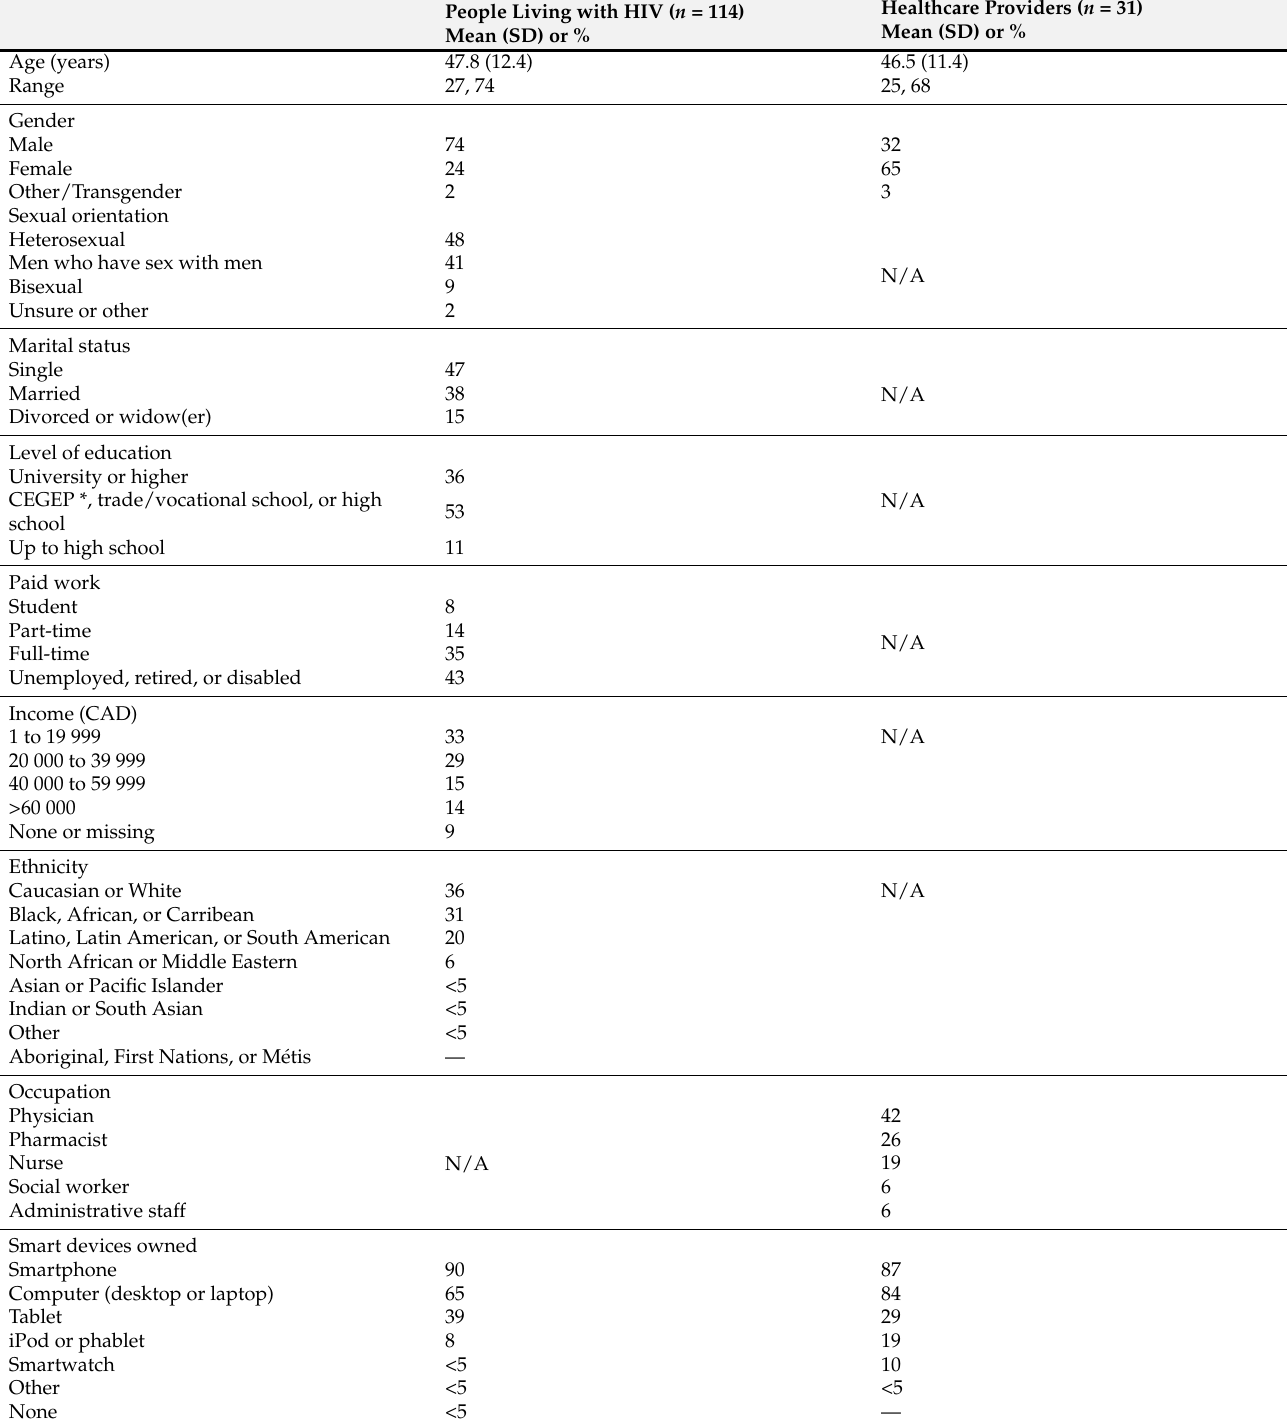
Table 1. Descriptive characteristics of people living with HIV and healthcare providers who participated in the